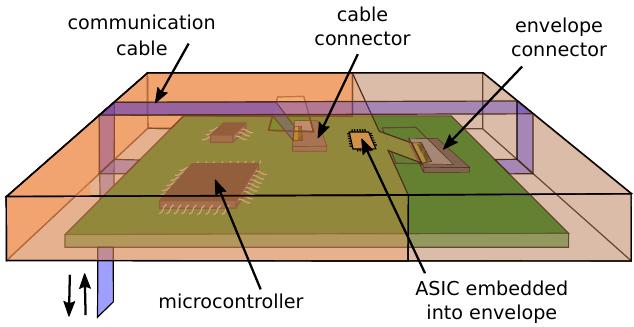
Figure 2: Schematic overview of the capacitive envelope protecting a